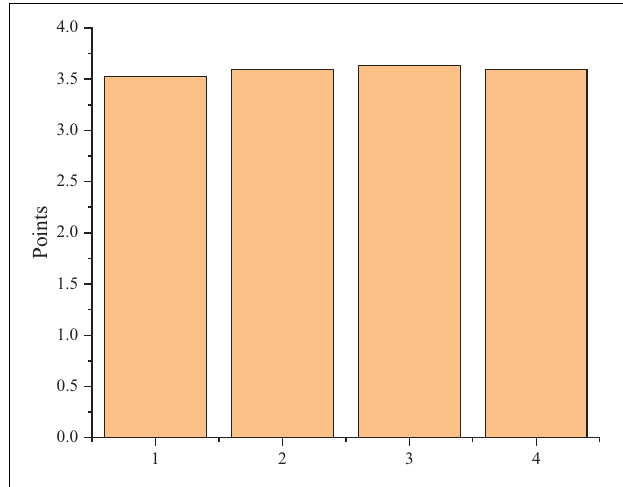
FIGURE 8 | Satisfaction with the learning strategies of MOOCs.